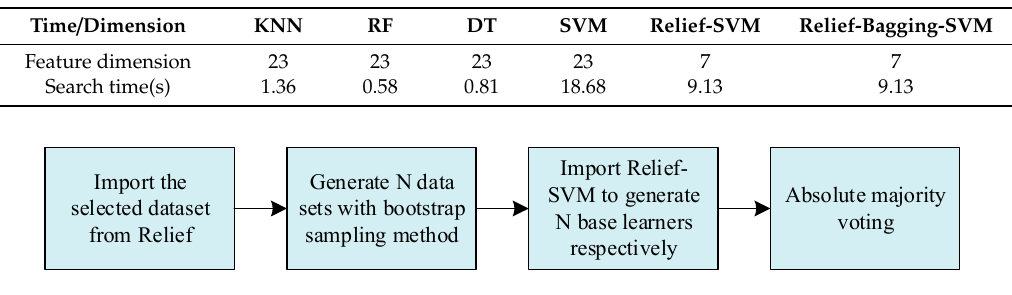
Figure 8. Relief ‐ bagging ‐ SVM algorithm flow. Figure 8. Relief-bagging-SVM algorithm